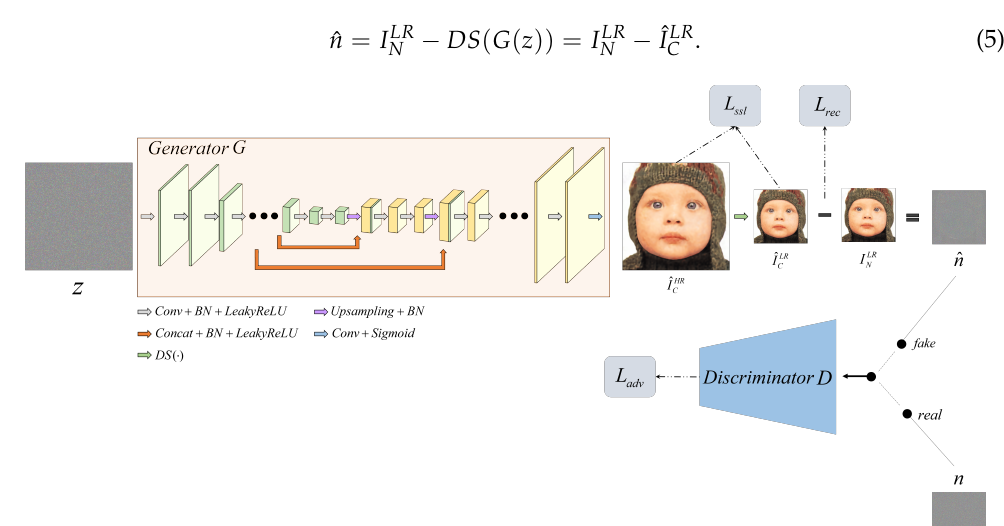
Figure 2. Overall architecture of the proposed model. Through a generator G , the input code tensor z is mapped to a noiseless HR image. For comparison with the target image, the generated image is downsampled via the downsampler. The discriminator D encourages G to learn the noise distribution in the target